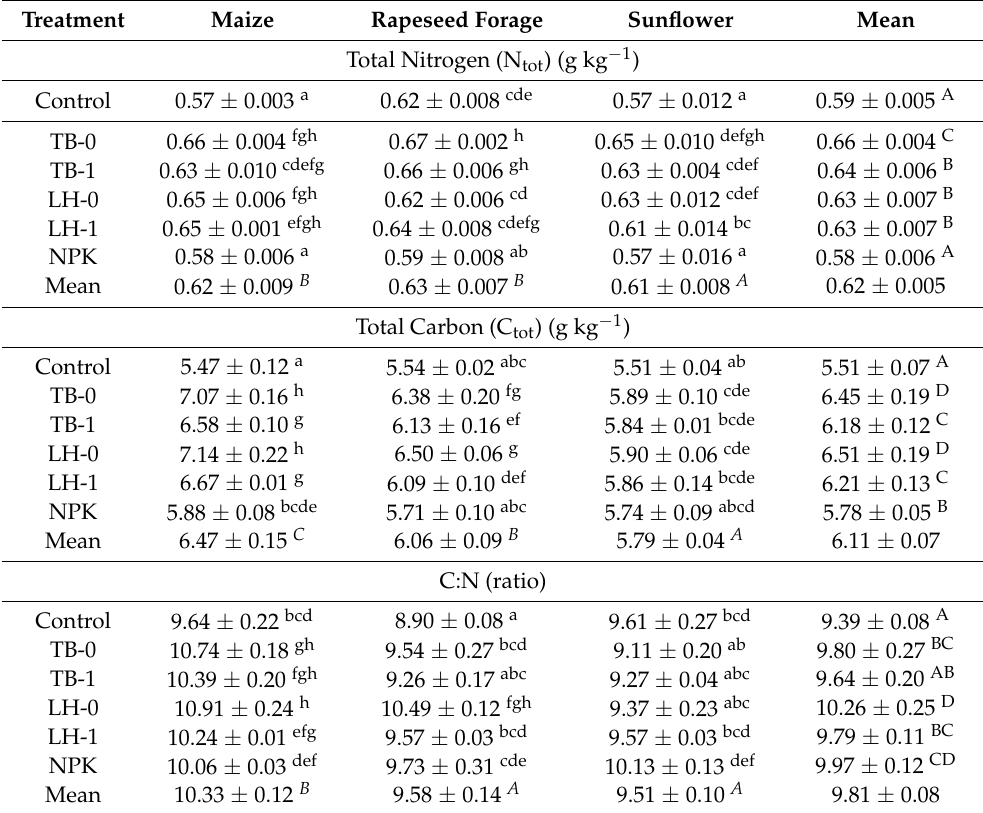
Table 5. The effect of PM application on the content of total nitrogen, total carbon, and C:N ratio in the soil after the first year of plant